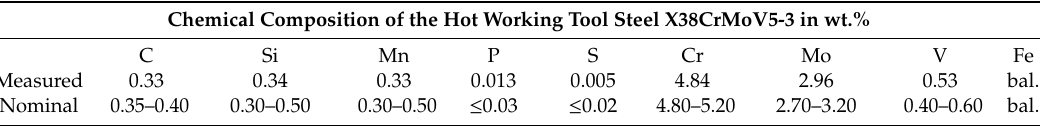
Table 1. Material properties of the hot working tool steel X38CrMoV5-3 (1.2367).